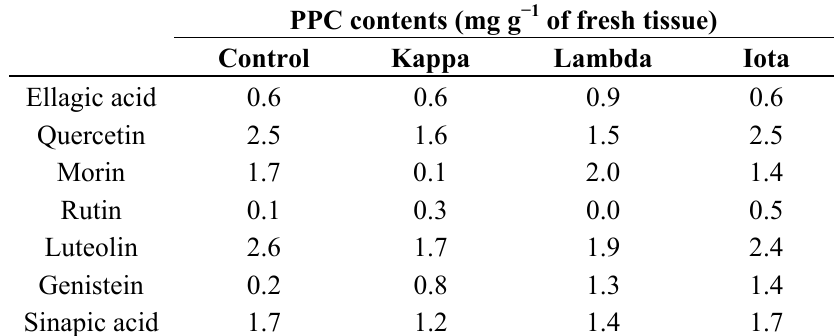
Table 1. Content of polyphenolic compounds (PPCs) in leaves of control Eucalyptus (control) and in trees treated with oligo-carrageenans (OCs) kappa lambda and